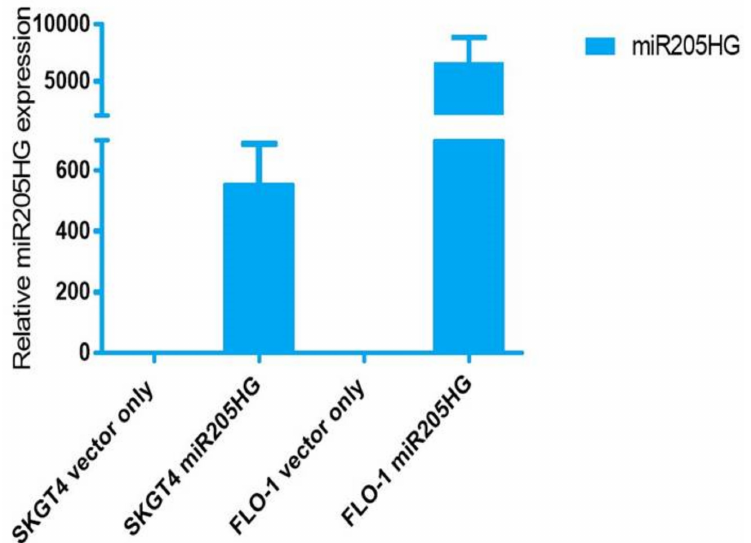
Figure 7. miR205HG expression in miR205HG -stably transfected clones. SKGT4 and FLO-1 EAC cell lines were miR205HG -stably transfected; qRT-PCR confirmed miR205HG overexpression in both of these cell lines relative to vector-only transfected cells.